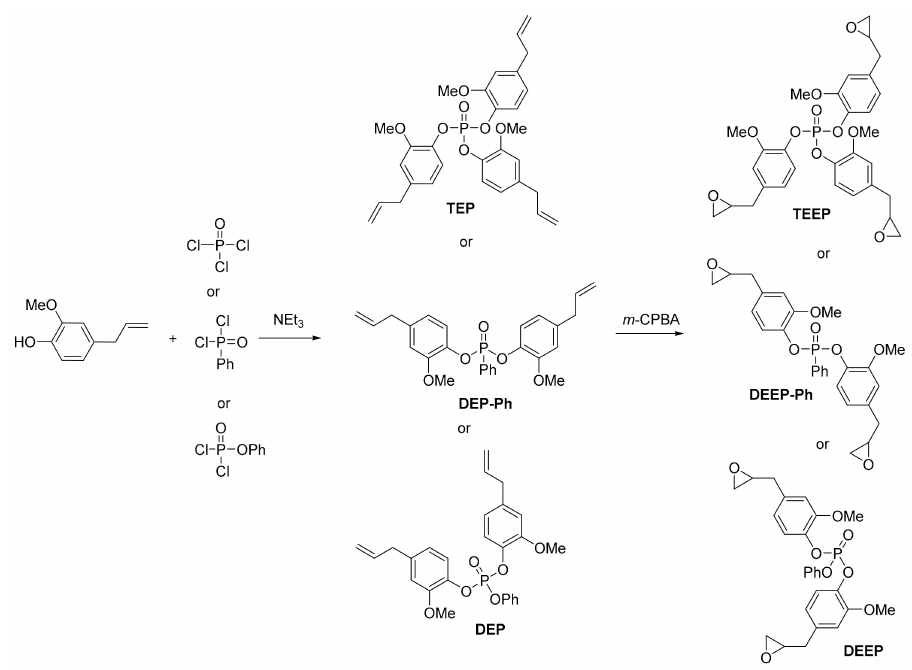
Scheme 1. Synthesis pathway for eugenol-based